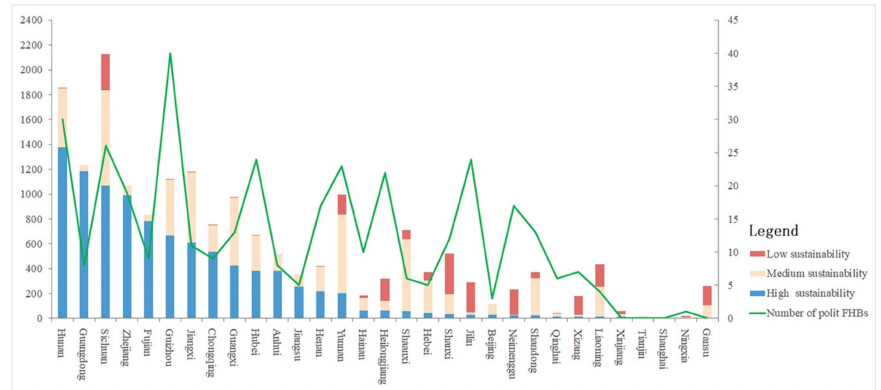
Figure 10. The FHB sustainability potential and numbers of the existing batches of pilot units in various provinces of China.